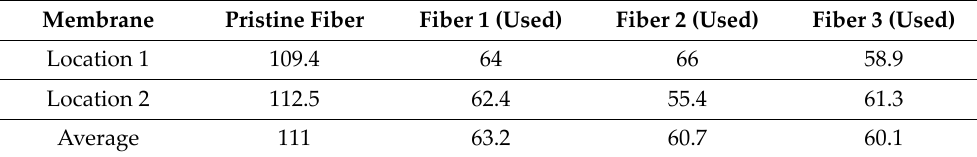
Table 4. Contact angle results of membranes used in Experiment 1 and